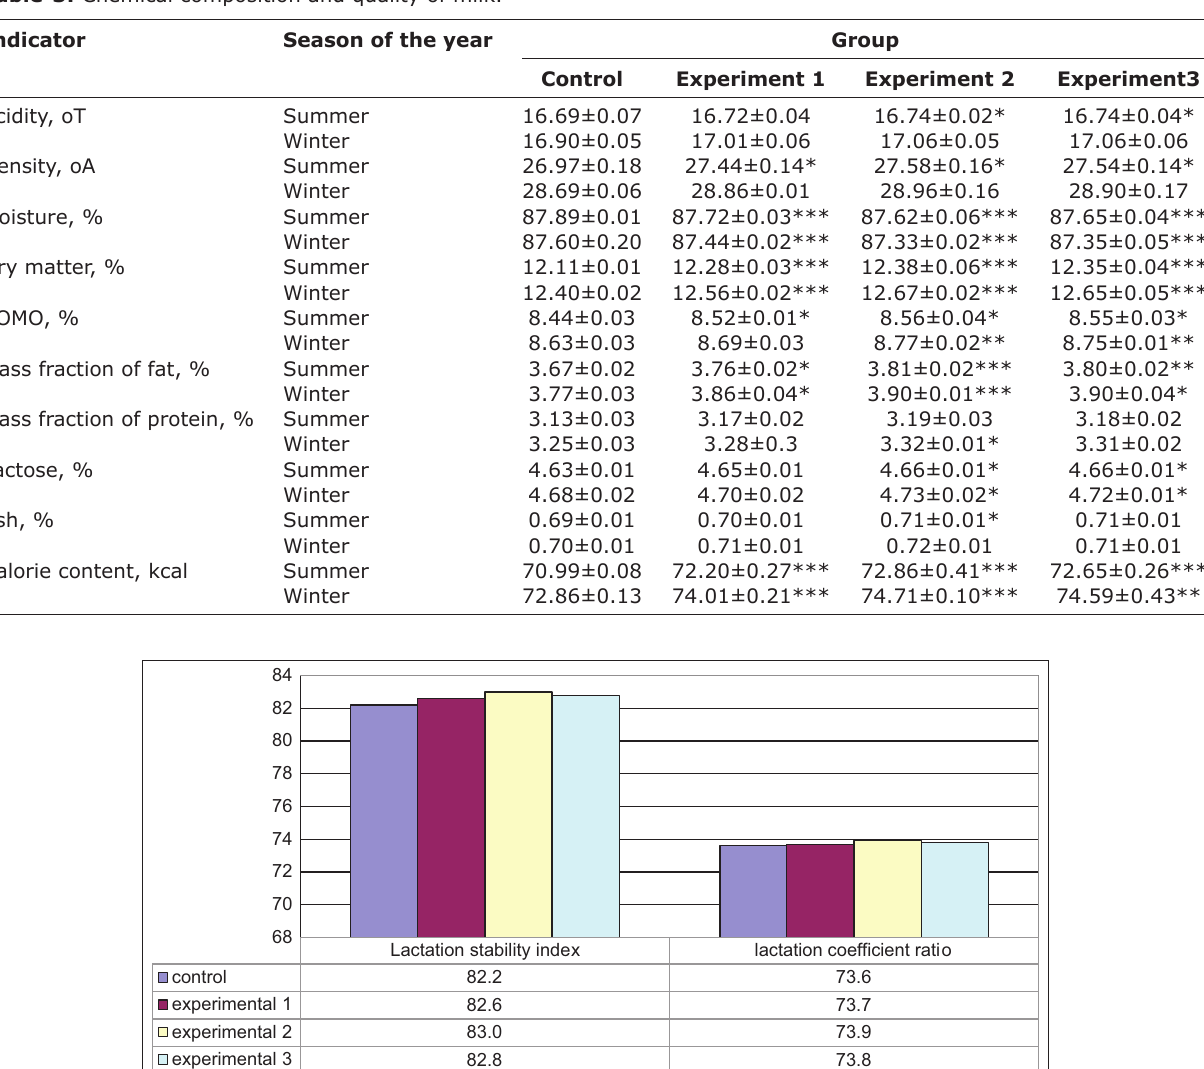
Figure-3: Lactation